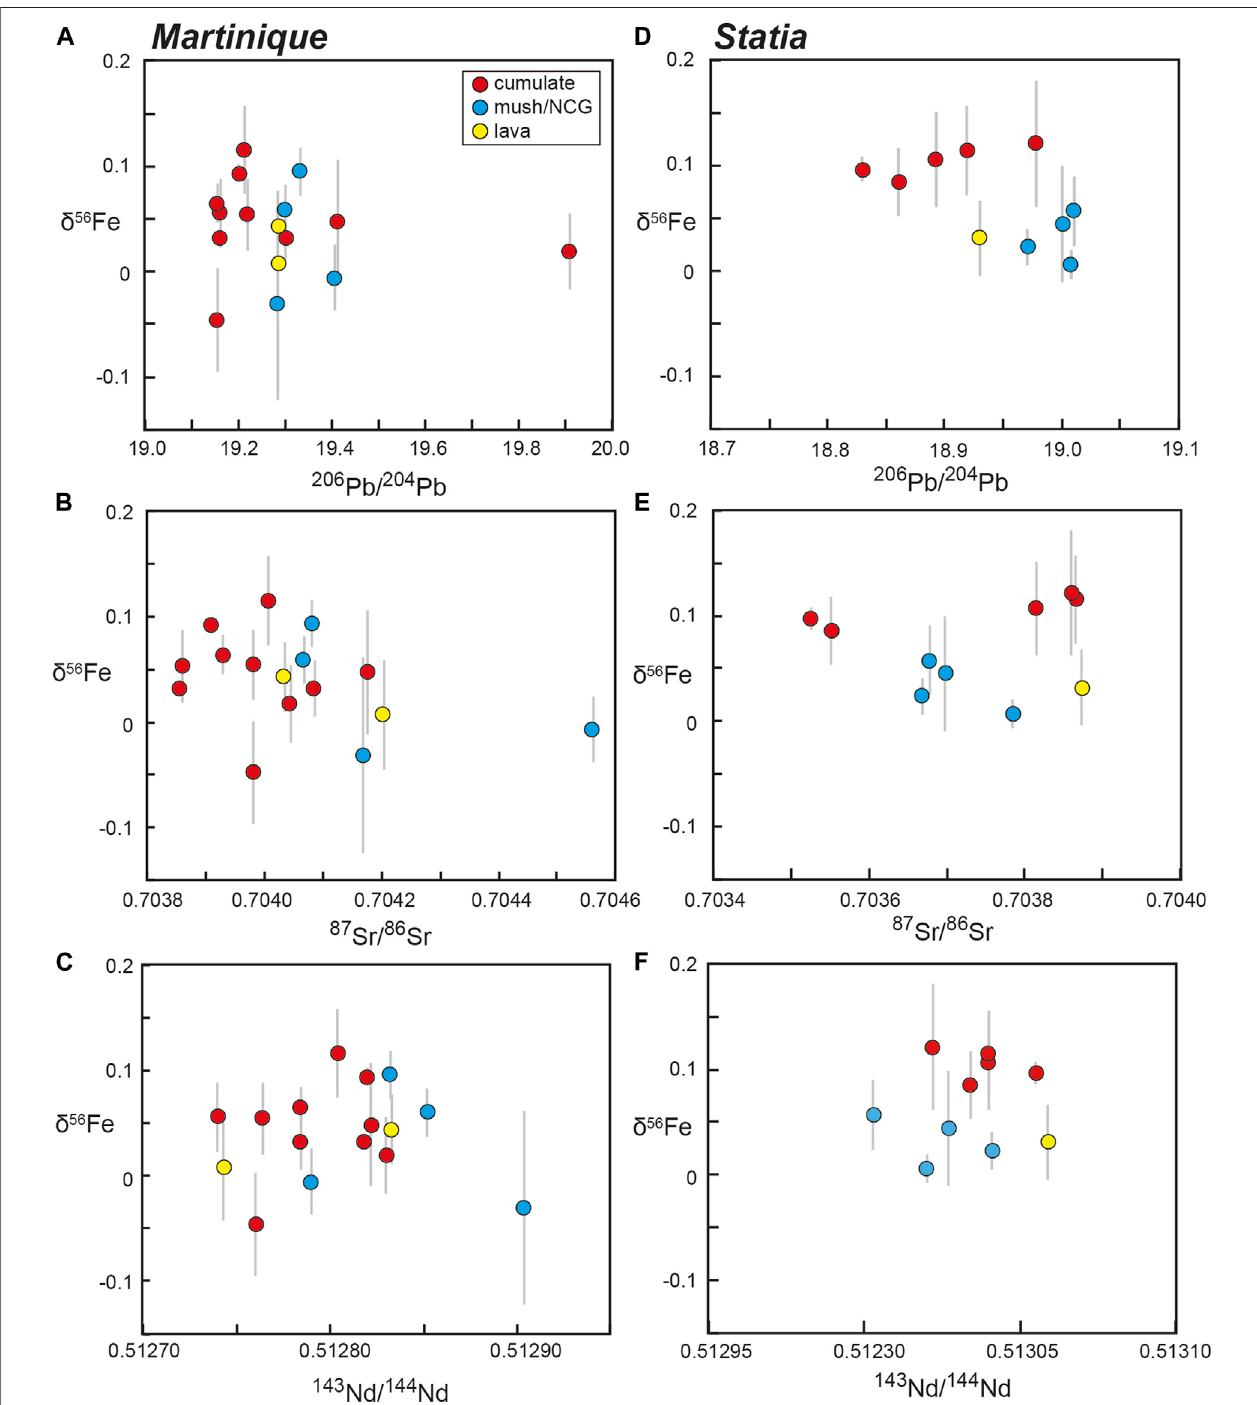
FIGURE 6 | Radiogenic isotopes ( 87 Sr/ 86 Sr, 143 Nd/ 144 Nd and 206 Pb/ 204 Pb) versus δ 56 Fe values of cumulates (red circles), NCG ’ s (blue circles) and lavas (yellow circles) from Martinique (A – C) and Statia (D – F)